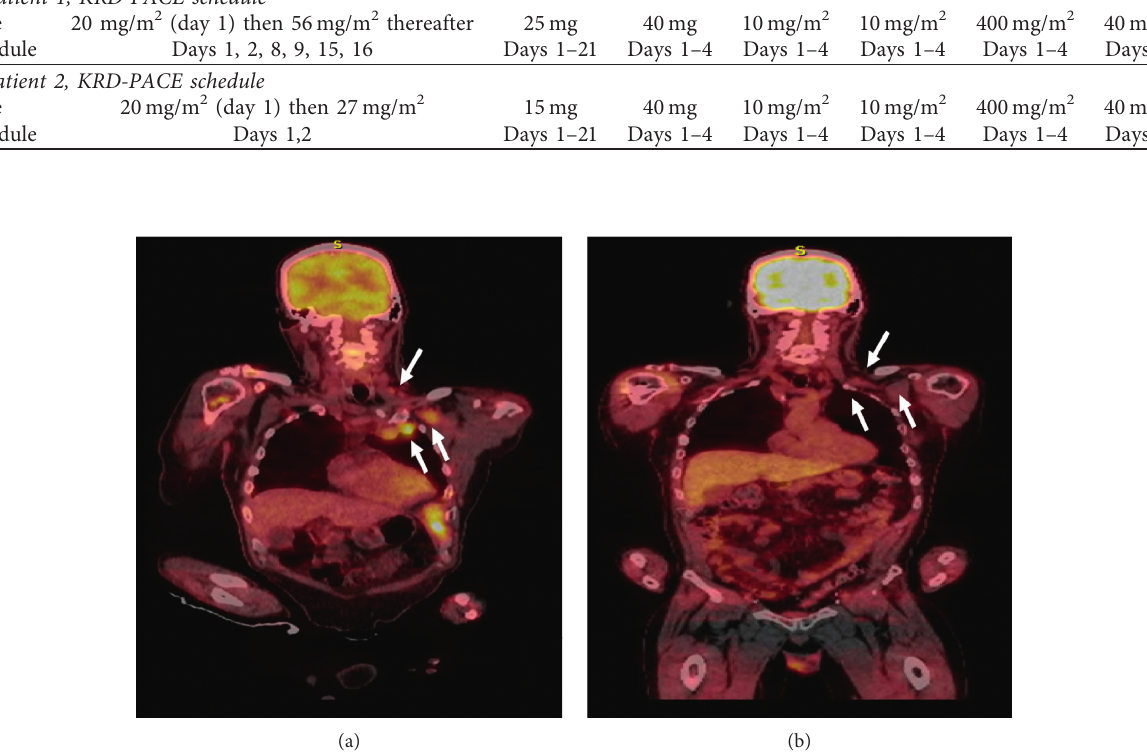
Figure 2: (a) 18F FDG PET-CTat relapse showing left cervical and supraclavicular adenopathy and numerous left subpectoral, axillary, and internal mammary adenopathy (white arrows). (b) 18F FDG PET-CT after 2 cycles of KRD-PACE revealing complete resolution of adenopathy.